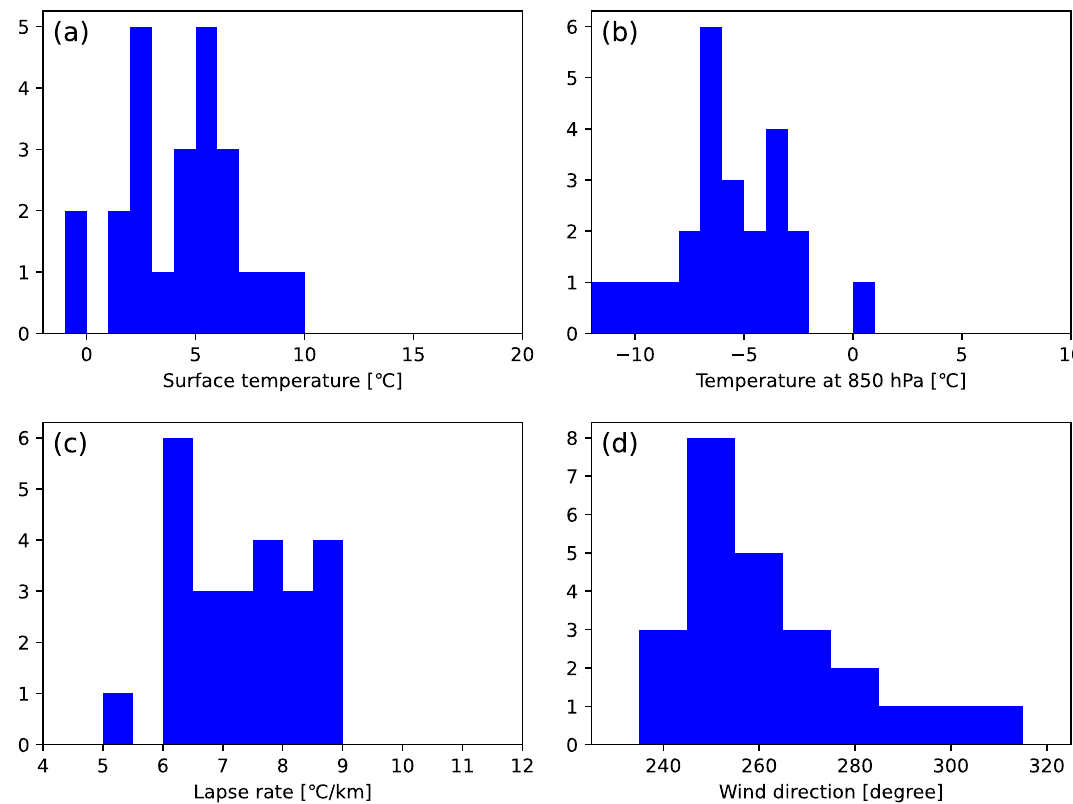
Fig. 6 Histograms of meteorological parameters in the glow-detection cases. a Surface temperature measured by AMeDAS stations. b The temperature at 850 hPa extracted from MSM. c Lapse rate between surface and 850 hPa height calculated with MSM. d Wind direction derived with radar images. The wind direction is where the wind comes from clockwise. For example, the direction 270 ◦ indicates that wind comes from the west toward the